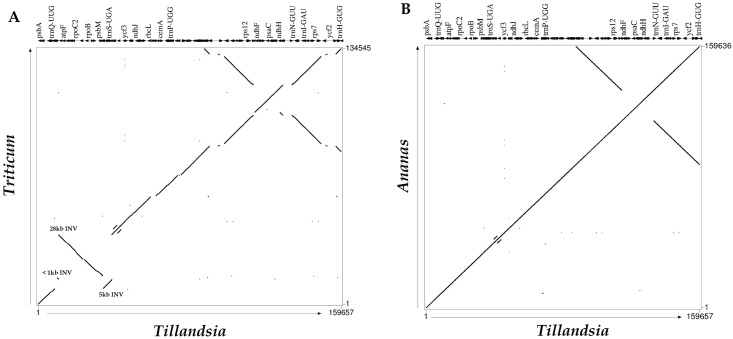
Percent identity plots.A. Tillandsia usneoides compared to Triticum aestivum, showing the three major inversions specific for grasses. B. Ananas comosus compared to T. usneoides.